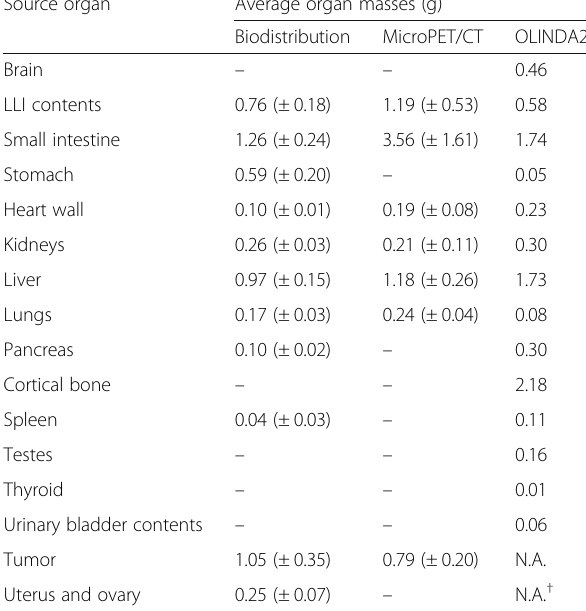
Table 1 Organ and tumor masses used for dosimetry calculations. Mean organ and tumor masses obtained by direct harvesting and weighing, as well as those obtained by PET/CT imaging segmentation, are shown together with the standard organ masses implemented in the mouse model 25 g of OLINDA2. The standard organ masses of OLINDA2 were used for dose estimations in the organs that were not harvested or segmented in the biodistribution and microPET experiments, respectively (indicated with –